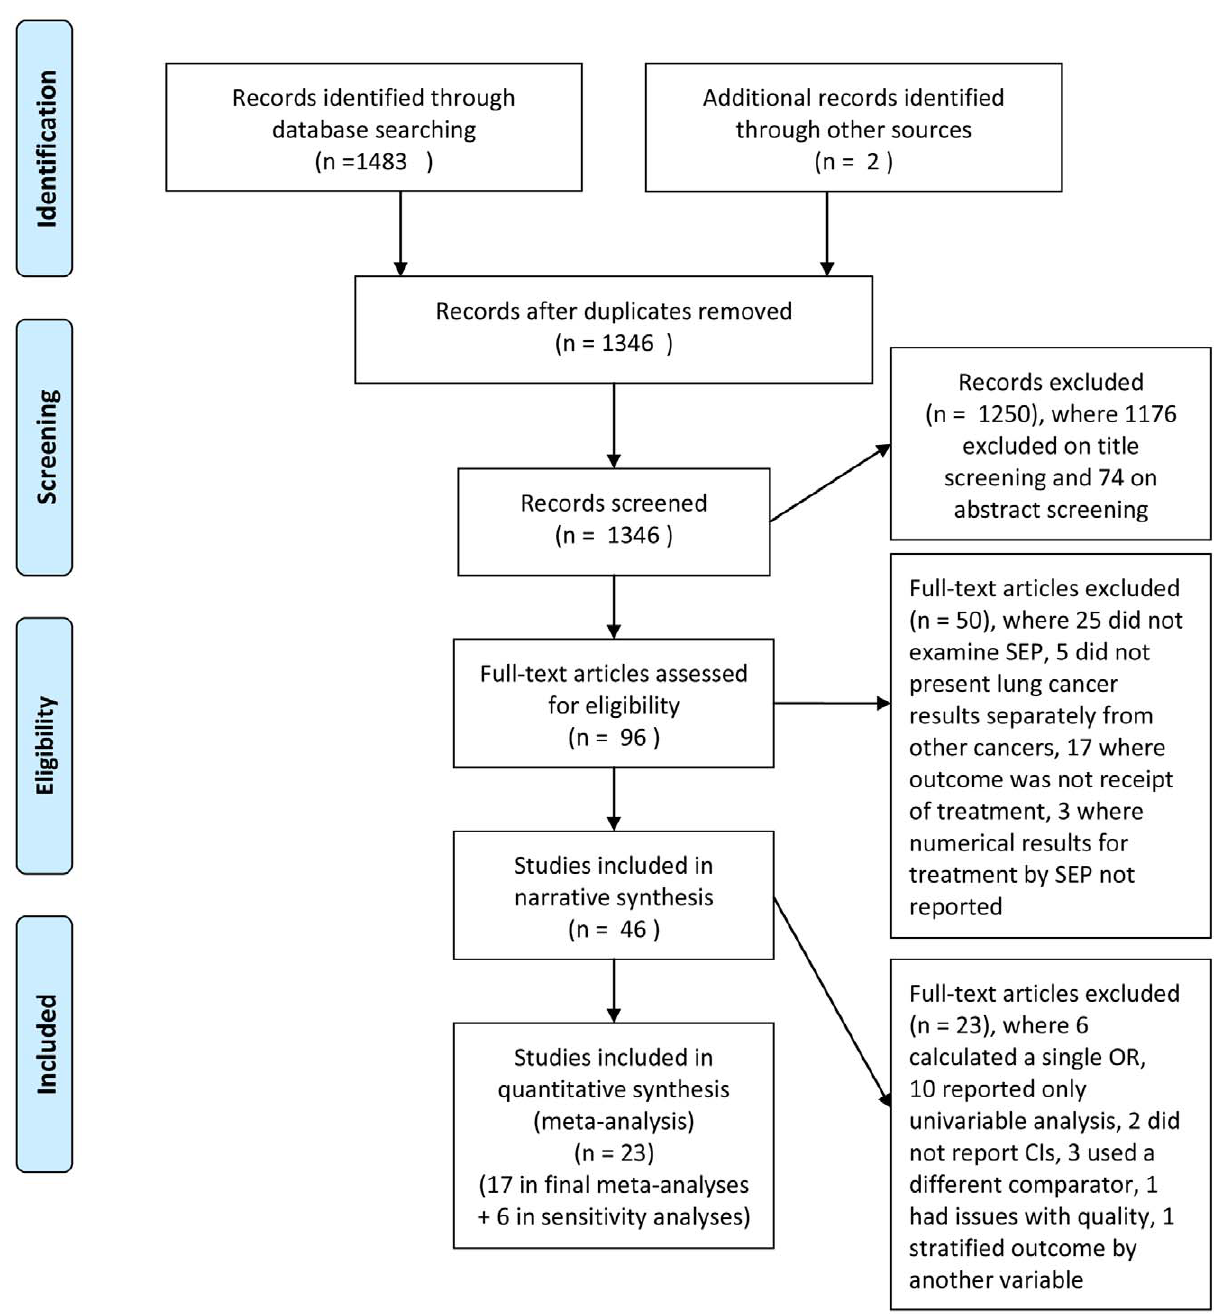
Figure 1. Flow diagram of study selection and exclusion. CI, confidence interval; SEP, socioeconomic position.